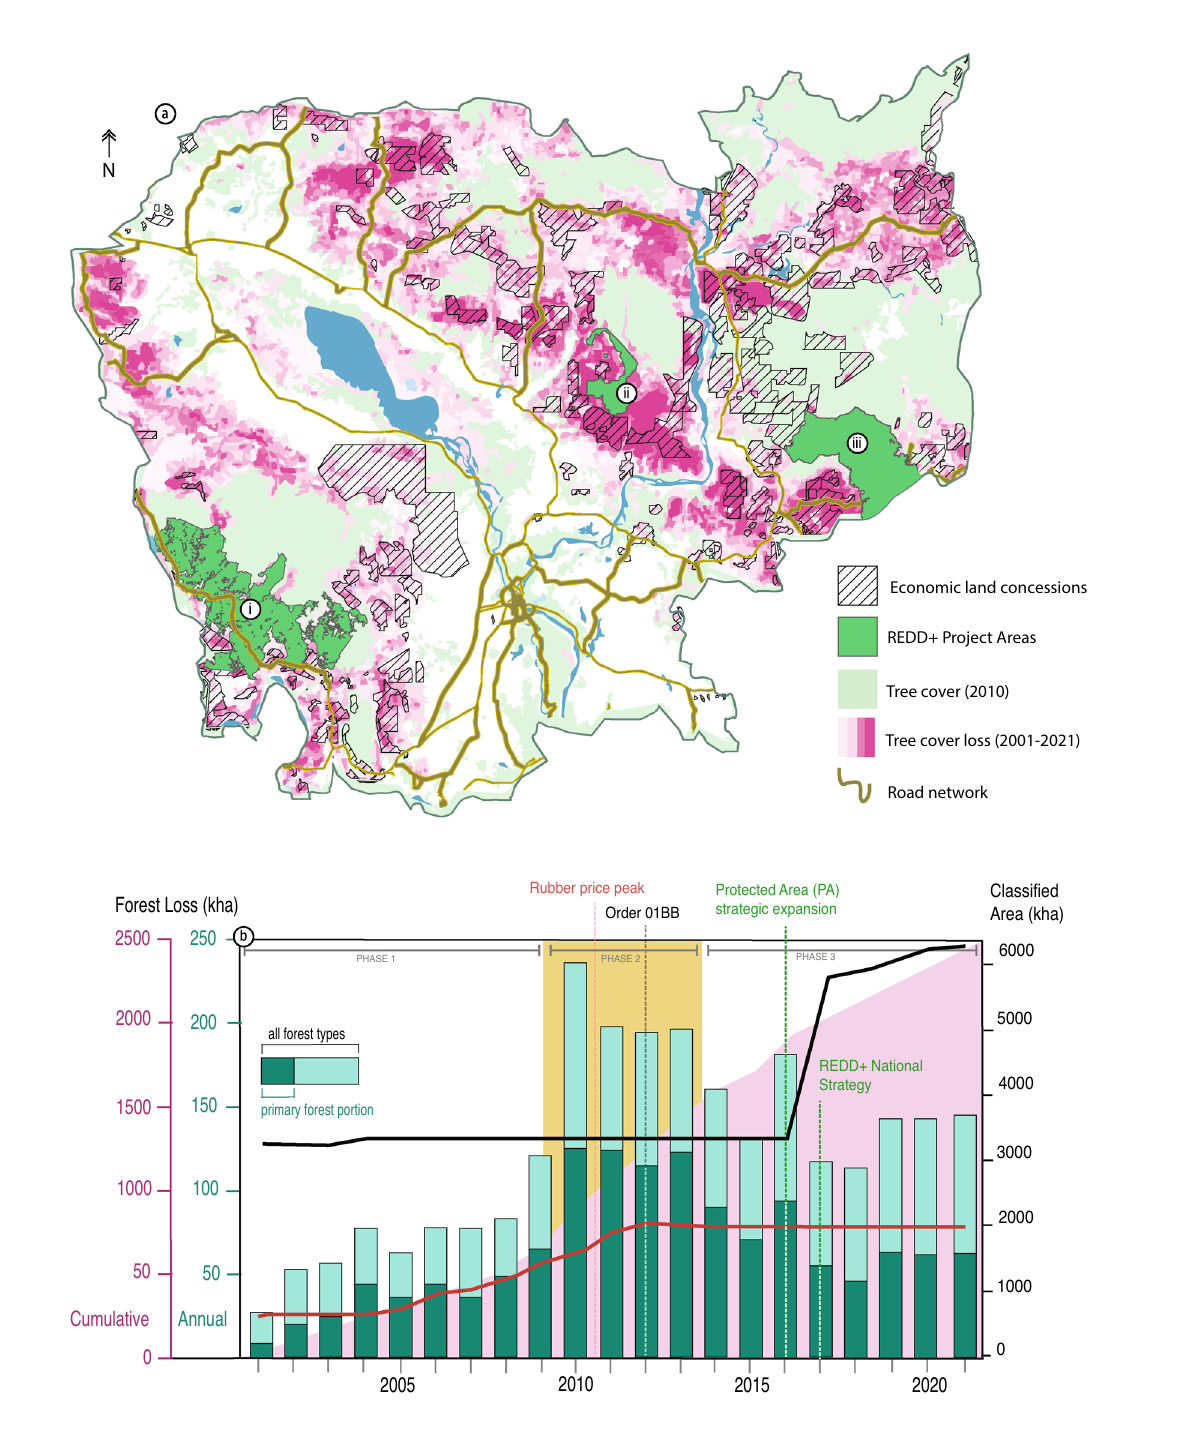
Figure. 1. Deforestation drivers in Cambodia. ( a ) Tree cover loss (2001–2021 7 ) with dark areas representing deforestation hotspots, CCB REDD+ project locations (i: Southern Cardamom, ii: Tumring, iii: Keo Seima) and Cambodia land concessions 25 . ( b ) Annual (bars) and cumulative (shaded area) deforestation in Cambodia from 2001 to 2021 7 , occurring in 3 phases with peak deforestation from 2010 to 2013 correlated to a spike in rubber price 14 and peak in hectares of land classified as Economic Land Concessions (ELCs; red line) 25 . Hectares classified as Protected Area in black 6 . Basemap and layers accessed from Global Forest Watch (Creative Commons CC BY 4.0) 15 , finalized on Adobe Illustrator (v26.2.1) 16